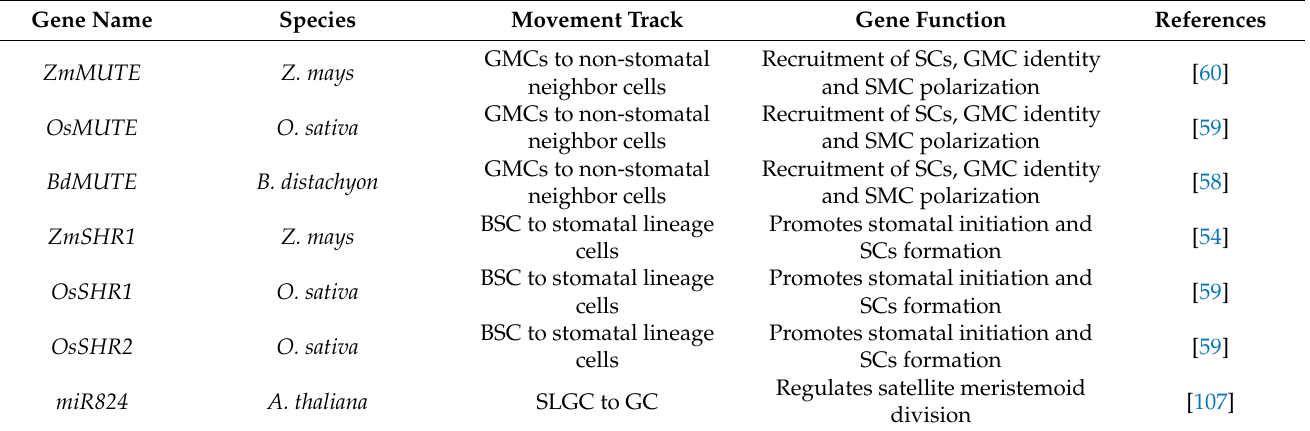
Table 1. Experimental verified mobile factors involved in stomatal development in grasses and Arabidopsis